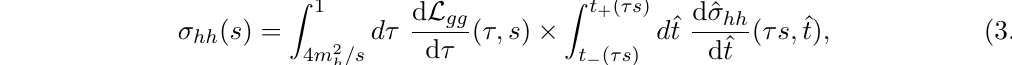
JHEP08(2021)100